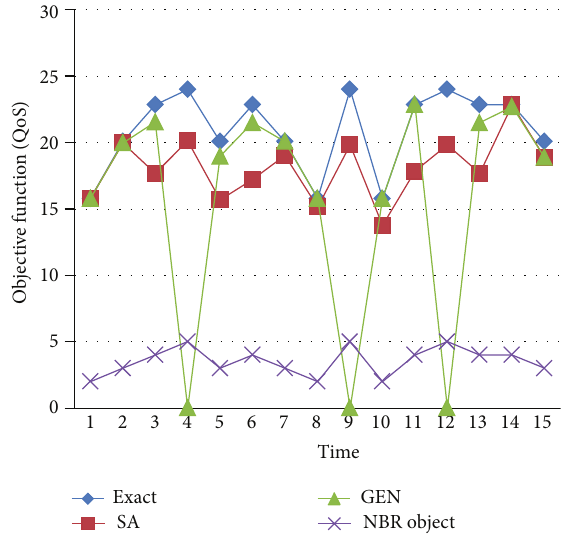
Figure 14: Number Object/QoS variation for exact, genetic (GEN, nbr it = 50 ), and simulated annealing (RS, fact = 0.8 ).